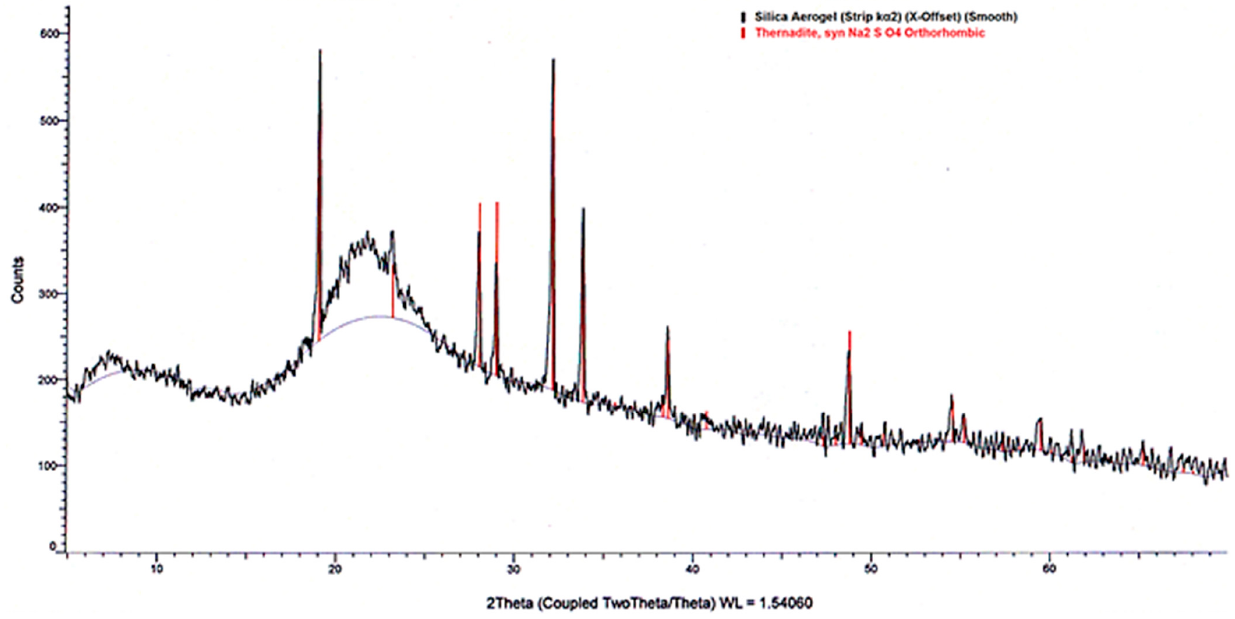
Figure 5. X-Ray Diffraction (XRD) pattern of the silica aerogel sample. Table 2. Composition of the silica aerogel sample obtained from the X-Ray Fluorescence (XRF)